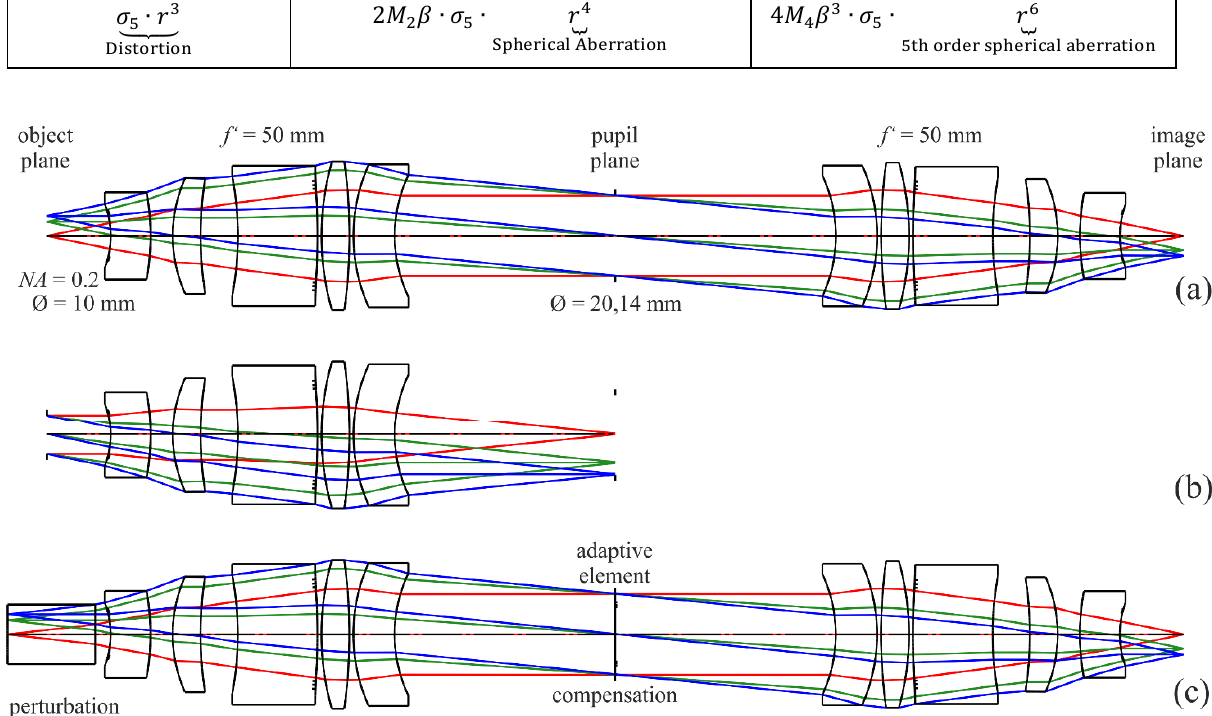
Fig. 2. Example system. (a) Relay system in its initial symmetric state without adaptive element. (b) Imaging of the entrance pupil at infinity to the conjugated pupil plane in the center of the relay system, where the adaptive element can be placed. (c) Relay system in its perturbed state with a glass plate inserted in object space. A thin adaptive element is placed at the conjugated pupil plane and compensates for the 3 rd -order spherical aberration introduced by the glass plate. Different colors indicate different object points. On- axis object or pupil points are in red, zonal object or pupil points are in green, and edge points are in